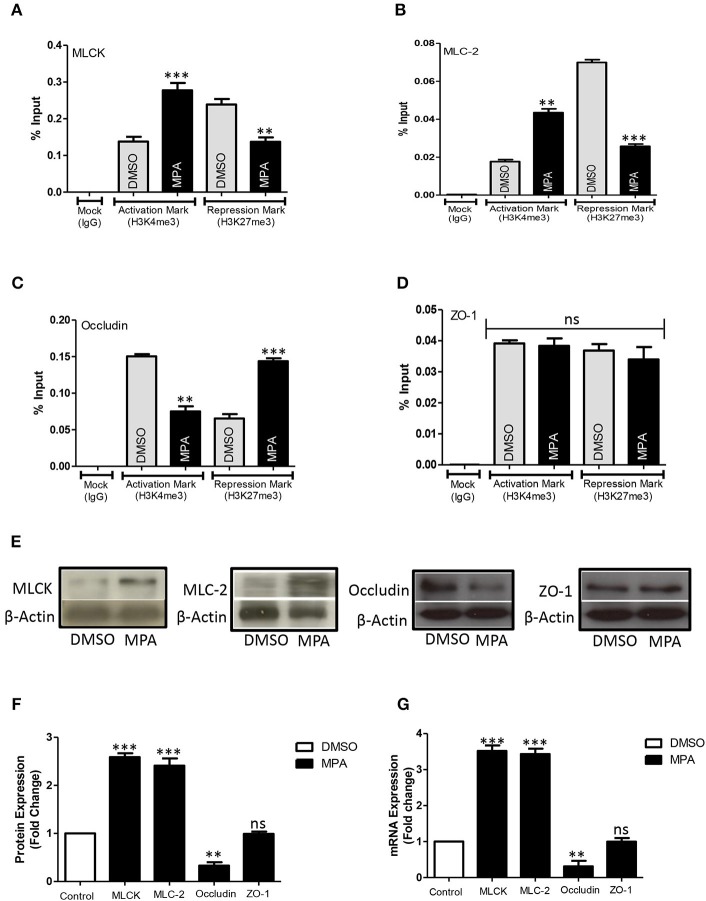
MPA causes epigenetic alteration of MLCK/MLC-2 pathway and tight junction genes (occludin). (A–D) Caco-2 cells were grown for 13 days post-confluence to form differentiated monolayers and then treated for 72 h with MPA or DMSO. ChIP was performed using anti-H3K4me3 (activation mark) or anti-H3K27me3 (repression mark), followed by real time PCR using promoter-specific primers of the target genes (MLCK, MLC-2, Occludin, and ZO-1). Levels of H3K4me3 or H3K27me3 was measured as %age input in the MPA treated cells as compared to the untreated cells. (E,F) Western blot analyses of MLCK, MLC-2, occludin, and ZO-1 after MPA treatment. Whole cell protein lysates were resolved on SDS-PAGE gels and immunoblotted using of anti-MLCK, anti-MLC-2, anti-occludin, and anti-ZO-1 specific antibodies. β-actin was used as a loading control for an equal amount of protein. Densitometric analysis was done using the Lab image software on three independent experiments. Differences between two groups were analyzed by the two-tailed Student's t-test and of more than two groups by One-way ANOVA with Bonferroni posttest. (G) DMSO treated Caco-2 monolayer cells. The values were expressed as means ± SEM. Asterisk indicates the significance (**P < 0.01, ***P < 0.001) when compared to control cells. (n = 3). ns, non-significant.